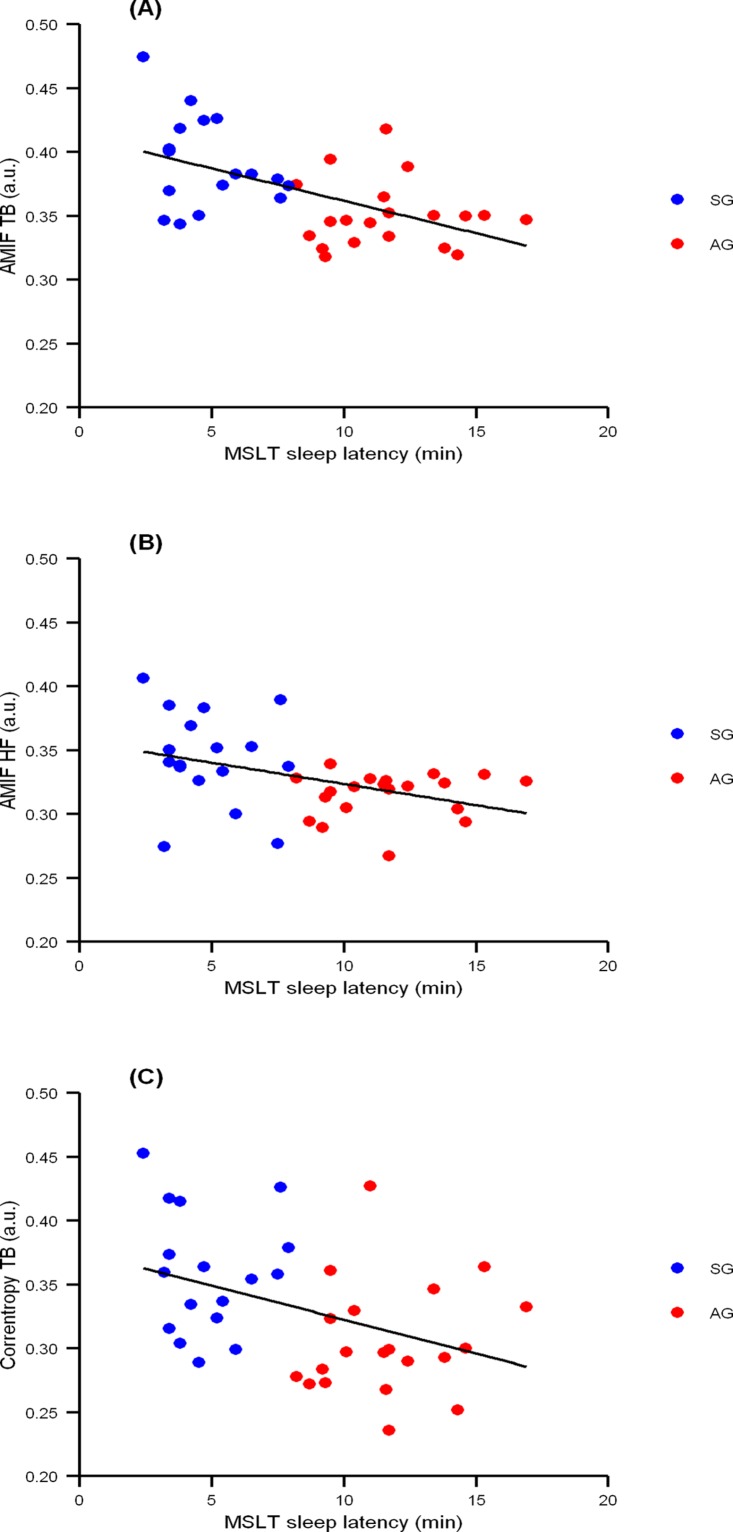
Correlation between AMIF-TB (A), AMIF-HF (B), and CORR-TB (C) with sleep latency from MSLT of all subjects, when using averages.Sleepy group, in blue, alert group, in red. Regression lines are represented in black. Note that patients with shorter sleep latencies showed an increased regularity of the RR rhythm in (A) rho -0.47, (B) rho -0.49 and (C) rho -0.41 (all p<0.05). Abbreviations: Auto-mutual information function (AMIF) in: total band (AMIF-TB), high-frequency band (AMIF-HF); Correntropy function in total band (CORR-TB); MSLT, Multiple Sleep Latency Test.